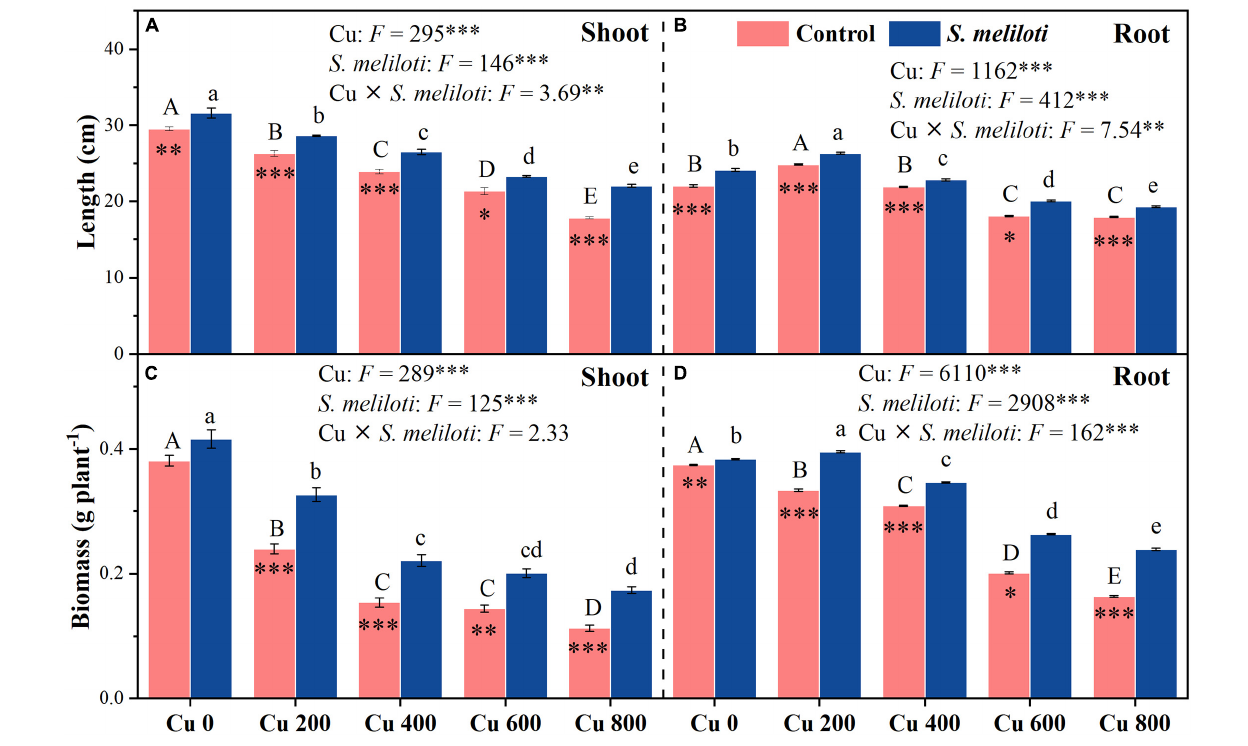
Frontiers in Microbiology |